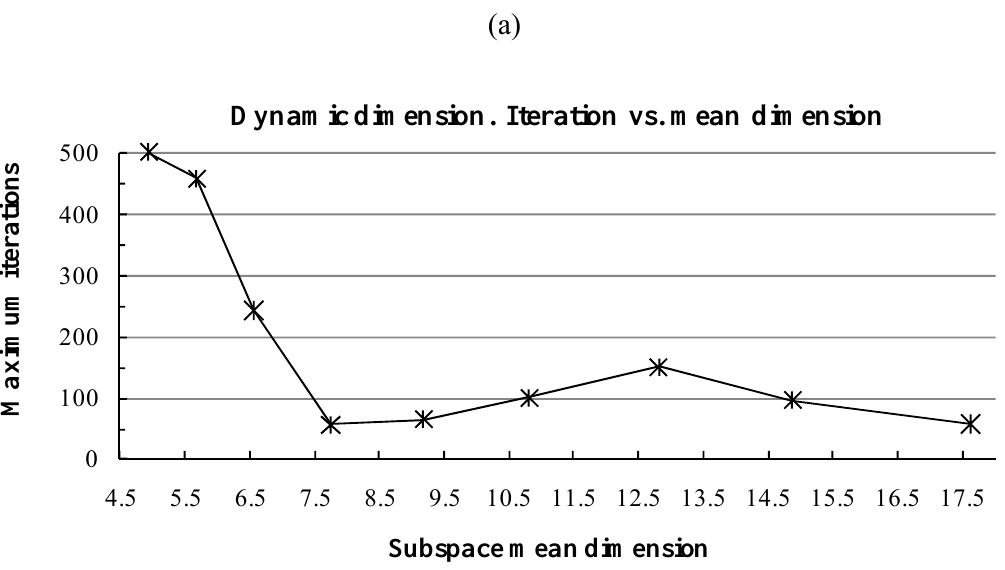
Subspace mean dimension